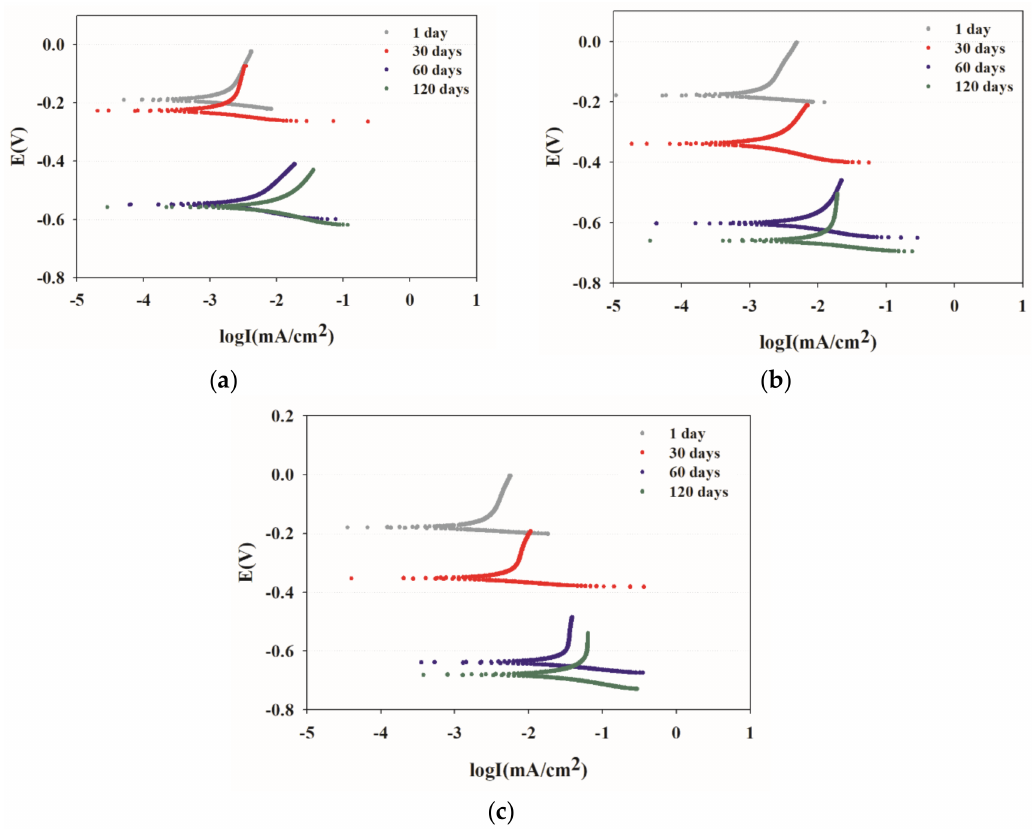
Figure 3. Polarization curve: ( a ) specimen A, ( b ) specimen B, and ( c ) specimen C.